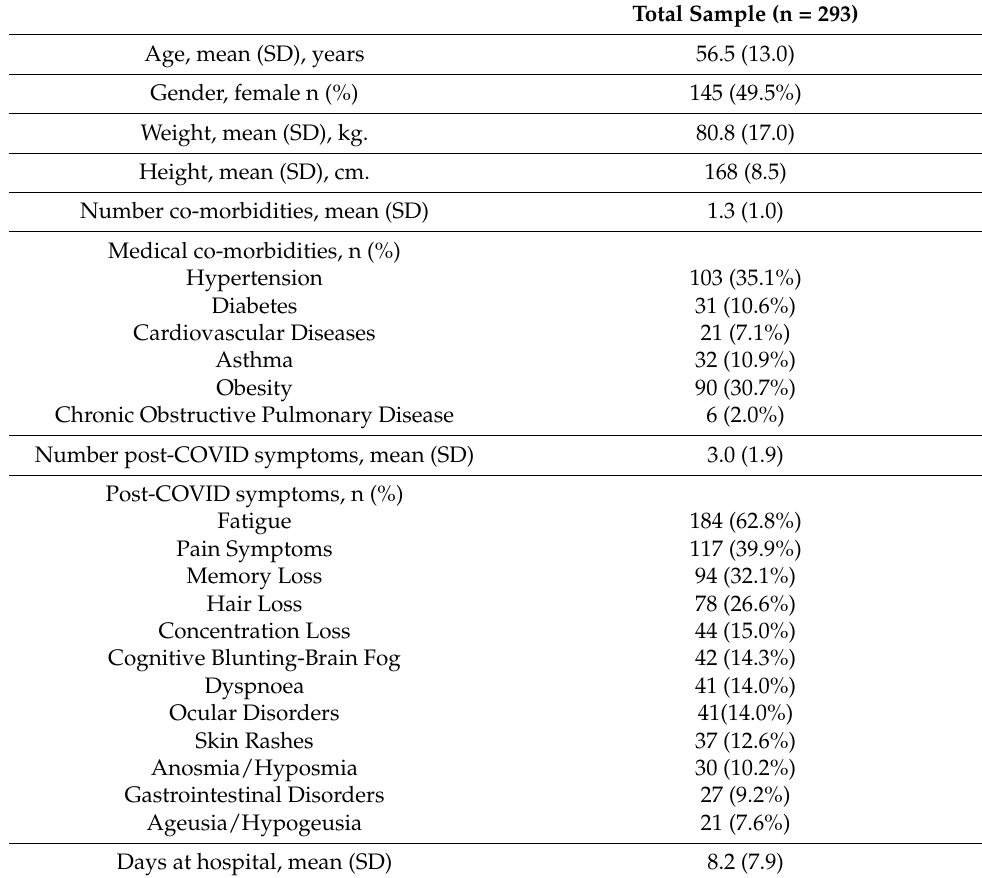
Table 1. Pre-Infection data and post-COVID symptoms of the total